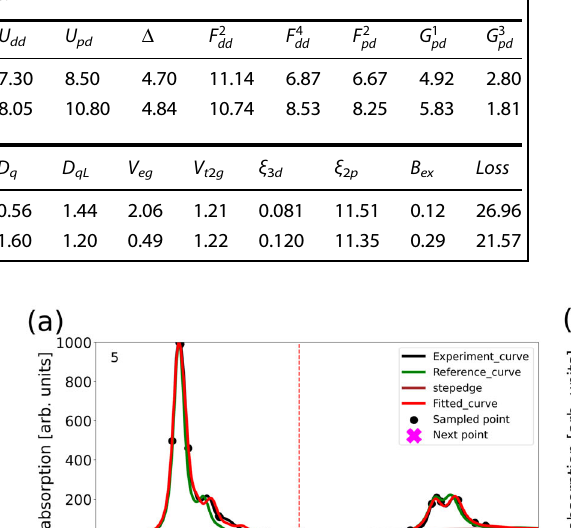
Table 1. The CTM model parameters comparison and the relative XAS curve loss.